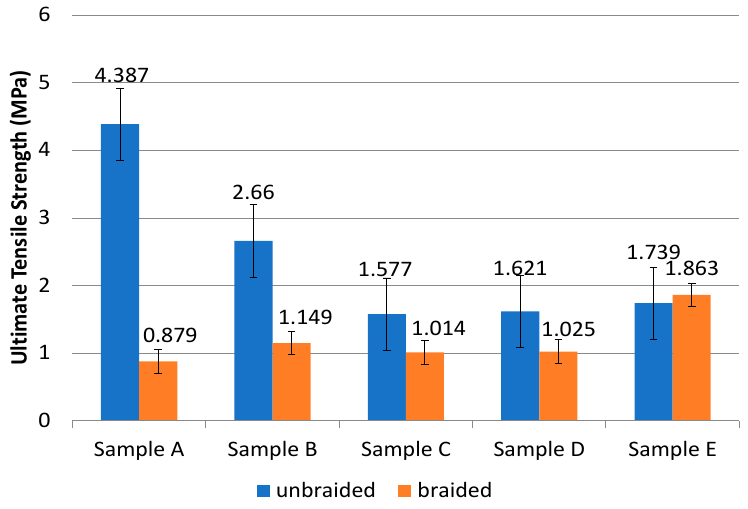
Figure 5. Graph of ultimate tensile strength (UTS) value of the samples with a composition of PLA:PCL; A (100:0), B (85:15), C (80:20), D (70:30), and E (0:100) in Table 3. The results of tensile strength of the samples.